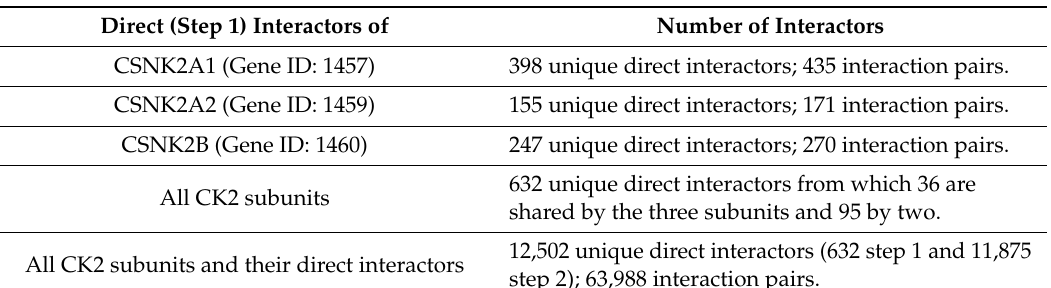
Table 1. CK2 subunits interactors extracted from a human protein–protein interaction network built